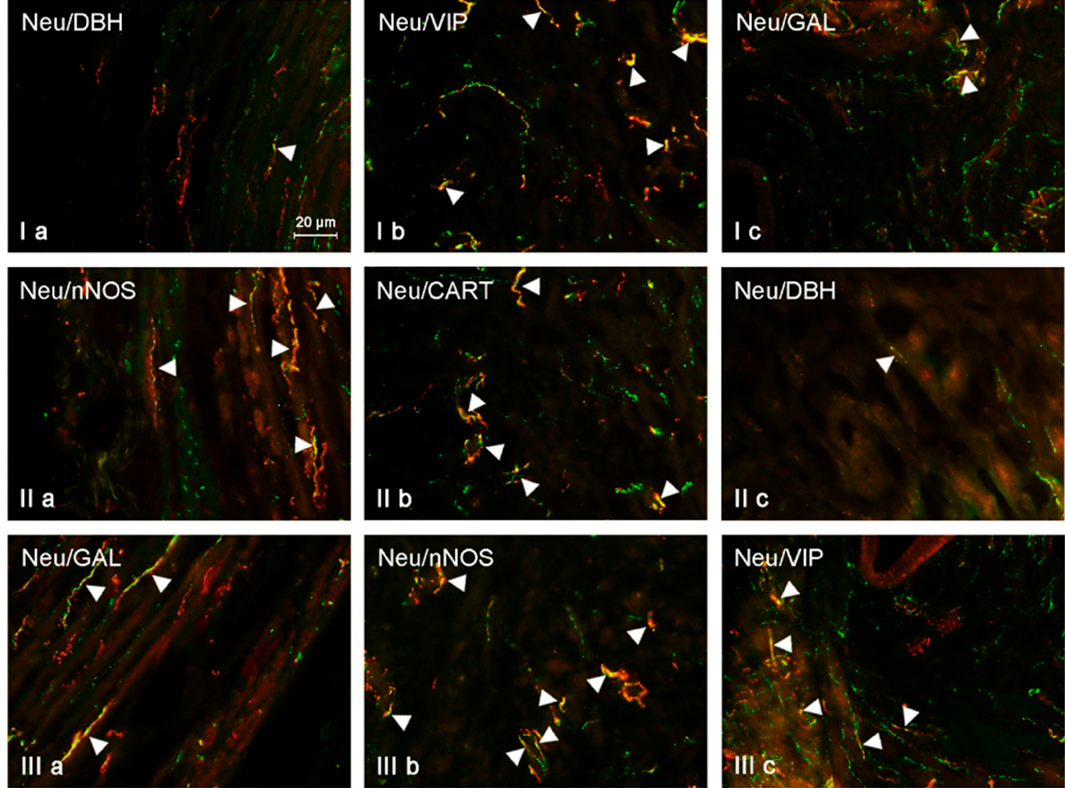
Figure 3. NRG-positive nerves (NRG-1+ green) immunoeractive to DBH, SP, VIP, nNOS, GAL, and CART (red) in the muscular layer of the uterine horns of control animals ( a ) and pigs treated with low ( b ) and high ( c ) dose of bisphenol A. Nerves simultaneously immunoreactive to NRG-1 and other substances (yellow) are indicated with arrowheads.